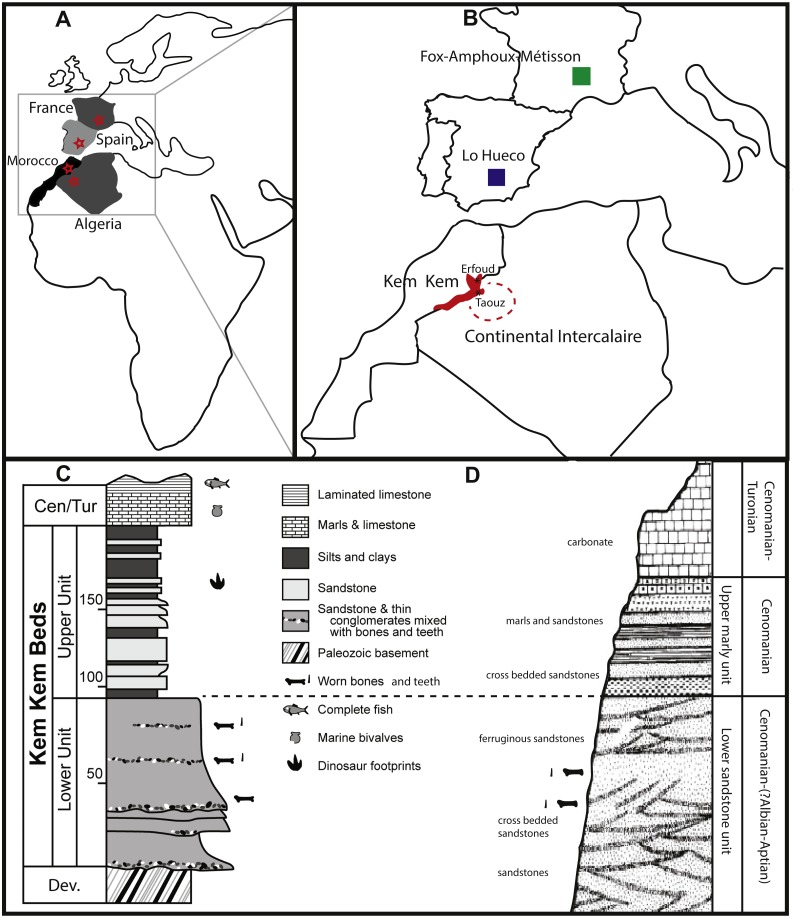
Geological setting of Kem Kem beds, Morocco, and Continental Intercalaire, Algeria.Taouz and Erfoud are indicated. localities of Lo Hueco, Spain, and France (FAM, AIX, Massecaps) are also portrayed. (A) Map of Europe and Africa. (B) Close-up of North Africa and Southern Europe. (C) stratigraphical column of Kem Kem beds (after Belvedere et al., 2013; Ibrahim et al., 2014). (D) stratigraphical column of Continental Intercalaire, Algeria, (after Forey, López-Arbarello & MacLeod, 2011).